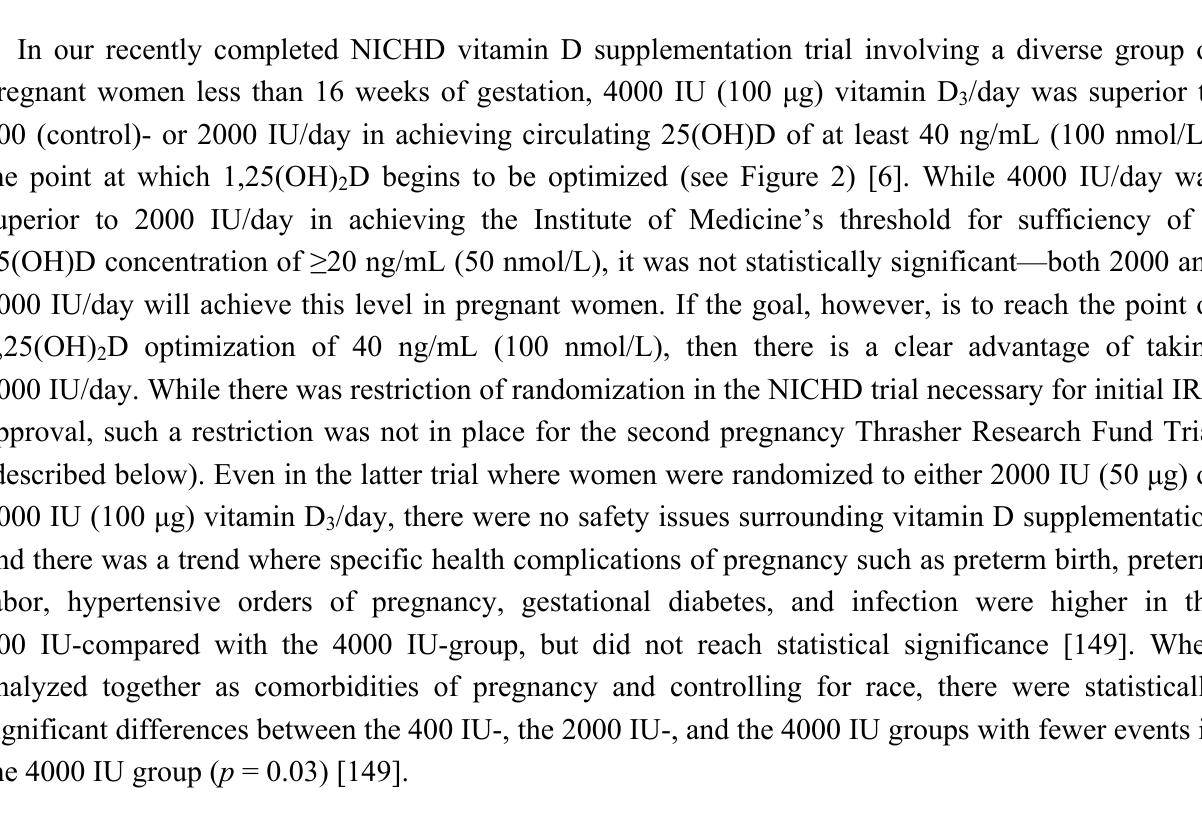
Figure 2. Relationship of circulating 25(OH)D on circulating 1,25(OH)D during pregnancy.